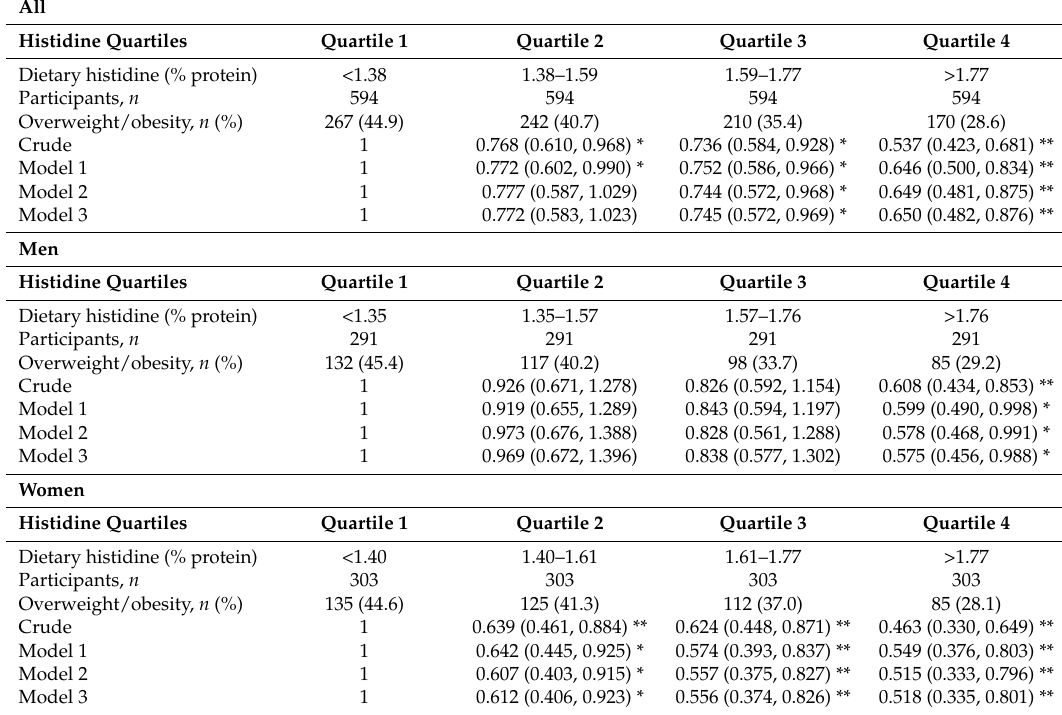
Multivariable-adjusted Odds ratio (OR) and 95% confidence interval (CI) of overweight/obesity by quartile of dietary